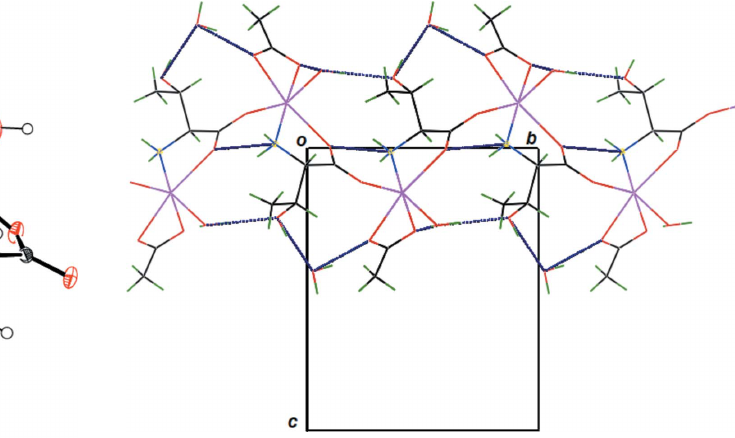
Figure 3 Packing diagram of the title complex viewed down the a axis, showing one polymeric chain forming hydrogen bonds (dashed blue lines) with lattice water molecules.